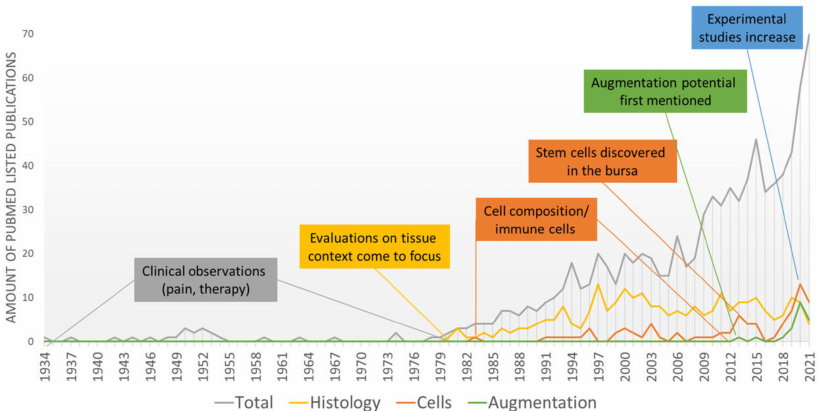
Figure 3. Overview of historical steps towards increased experimental research around the sub- acromial bursa: number of PubMed listed publications from 1934 to 2021 mentioning subacromial bursa OR subacromial bursitis (total) combined with the search terms “Histology”, “Cells”, and